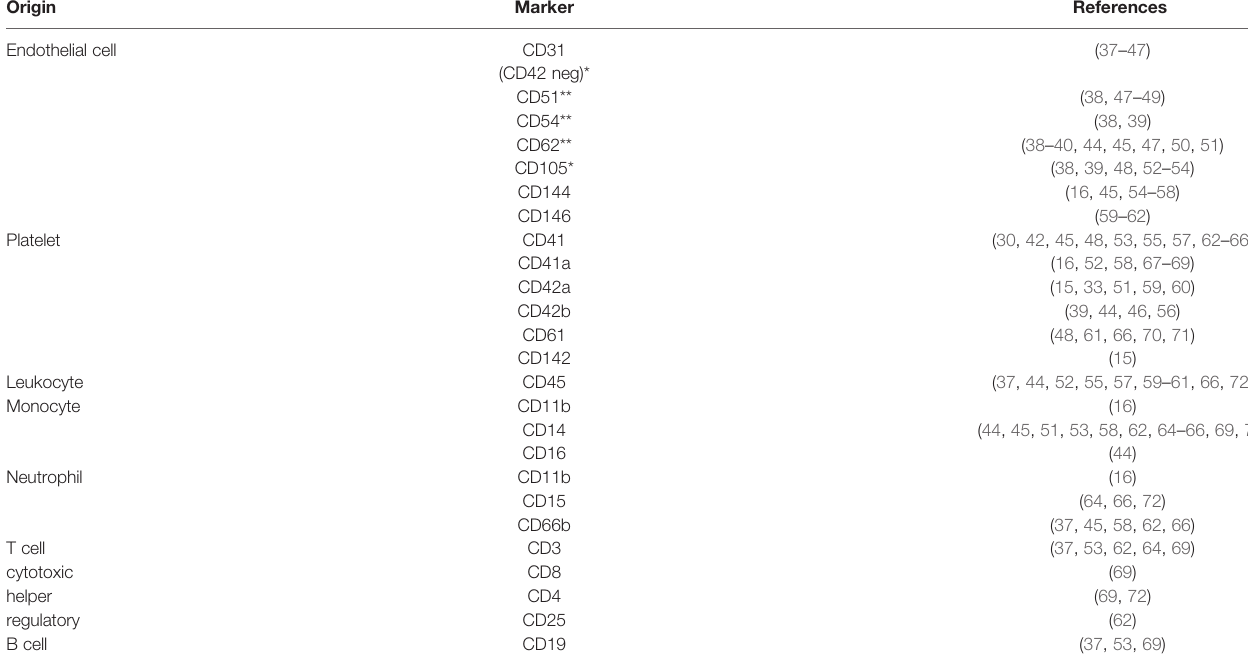
TABLE 1 | Markers used to classify the cellular origin of